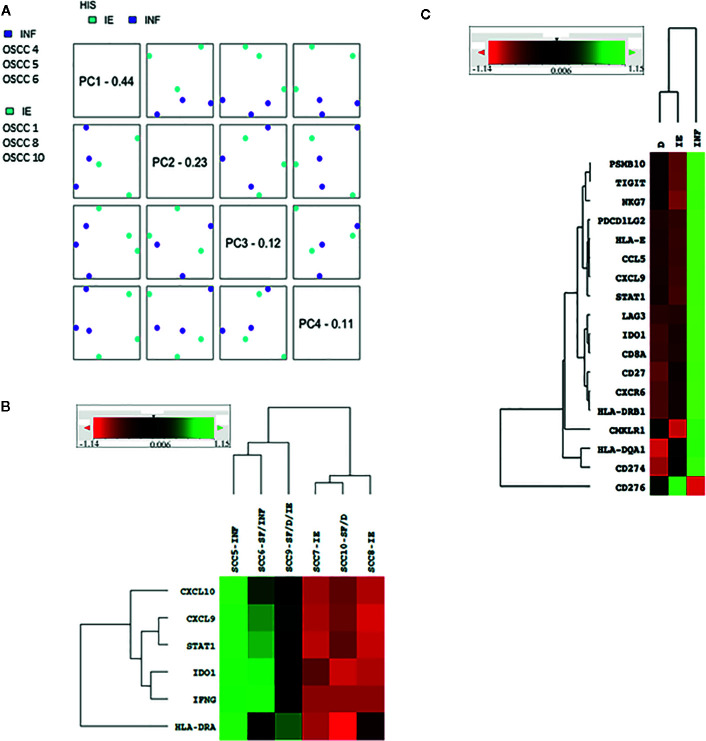
Validation of the Sema4D HIS subtypes using PCA and IFN-γ signature on nSolver 4.0 analysis. (A) PCA analysis of the HIS-IE and HIS-INF. (B) Heat map of the refined six IFN-γ-signature in representative HIS tumors. (C) Heat map illustrating final IFN-γ 18 gene signature between grouped cases of the three HIS subtypes (SCC 5&6 (INF), 7&8 (IE), 9&10 (ID). INF, inflamed; IE, immune excluded; ID, immune deserted; SF, stromal fibrosis. PCA, Principal component analysis. Green is positive; read is negative.